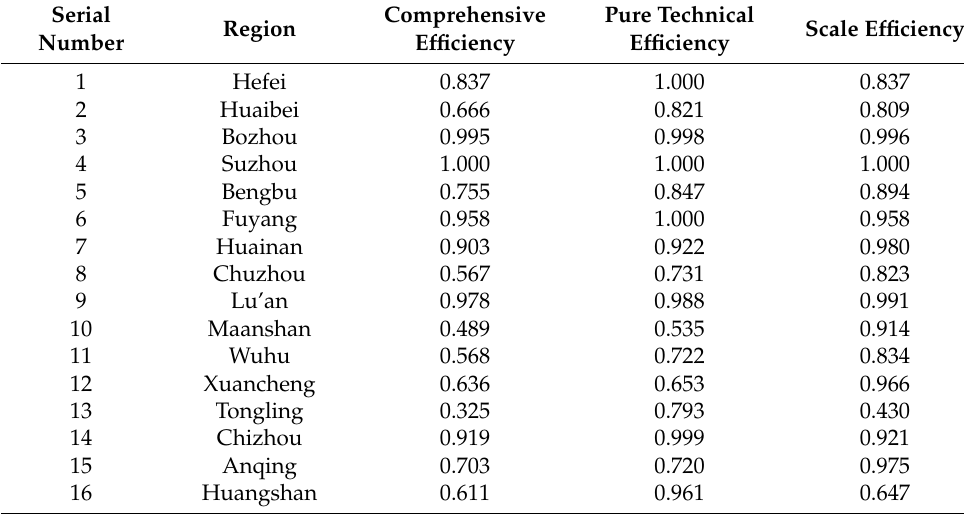
Table 4. DEA estimation results of the first stage: regional average.